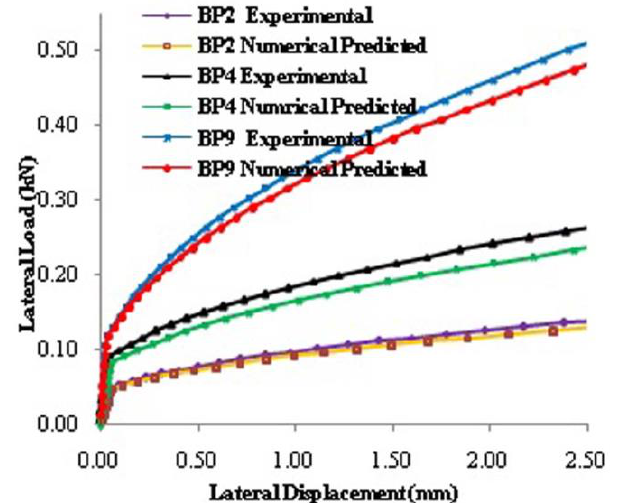
Fig. 7. Comparison between the experimental and predicted lateral load results at 3D pile spacing of bamboo pipe piles in loose layer in-between dense layers for slenderness ratio as 38.